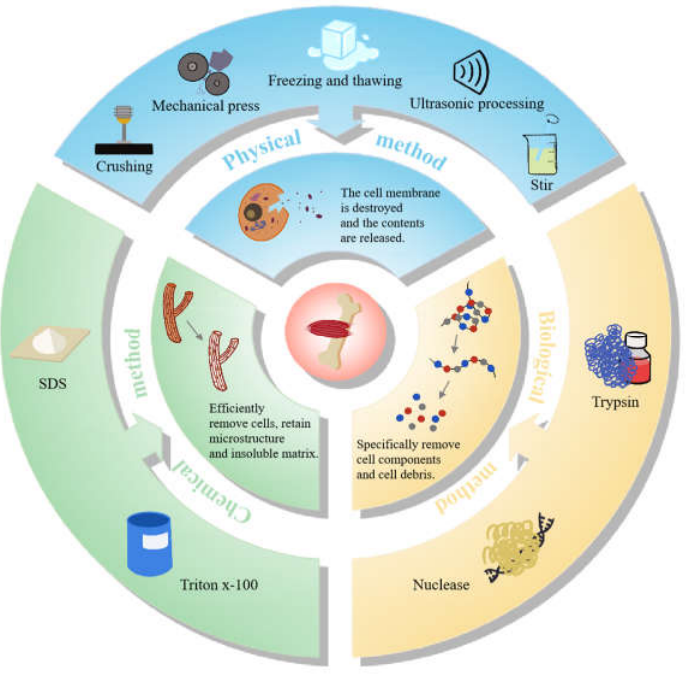
Figure 2. The methods for the preparation of animal-derived decellularized scaffolds.